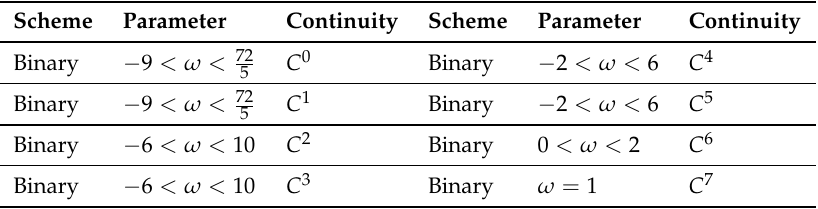
Table 4. Continuity order of binary scheme (Equation (3)).